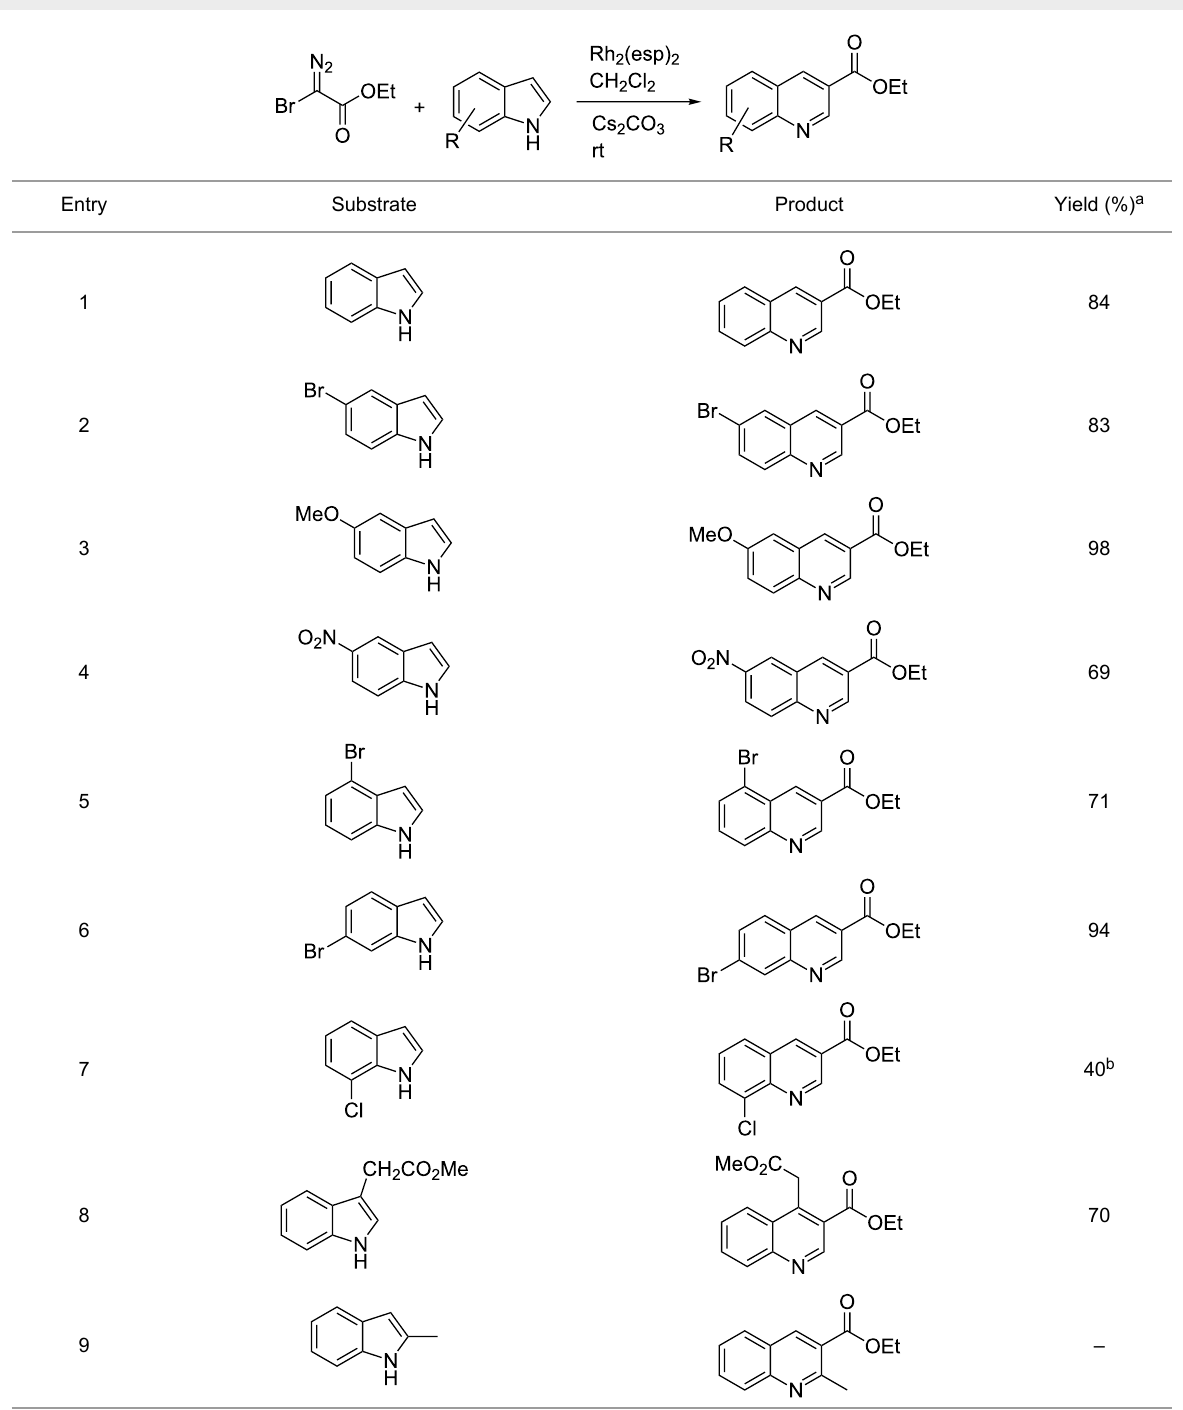
Table 1: Substrate